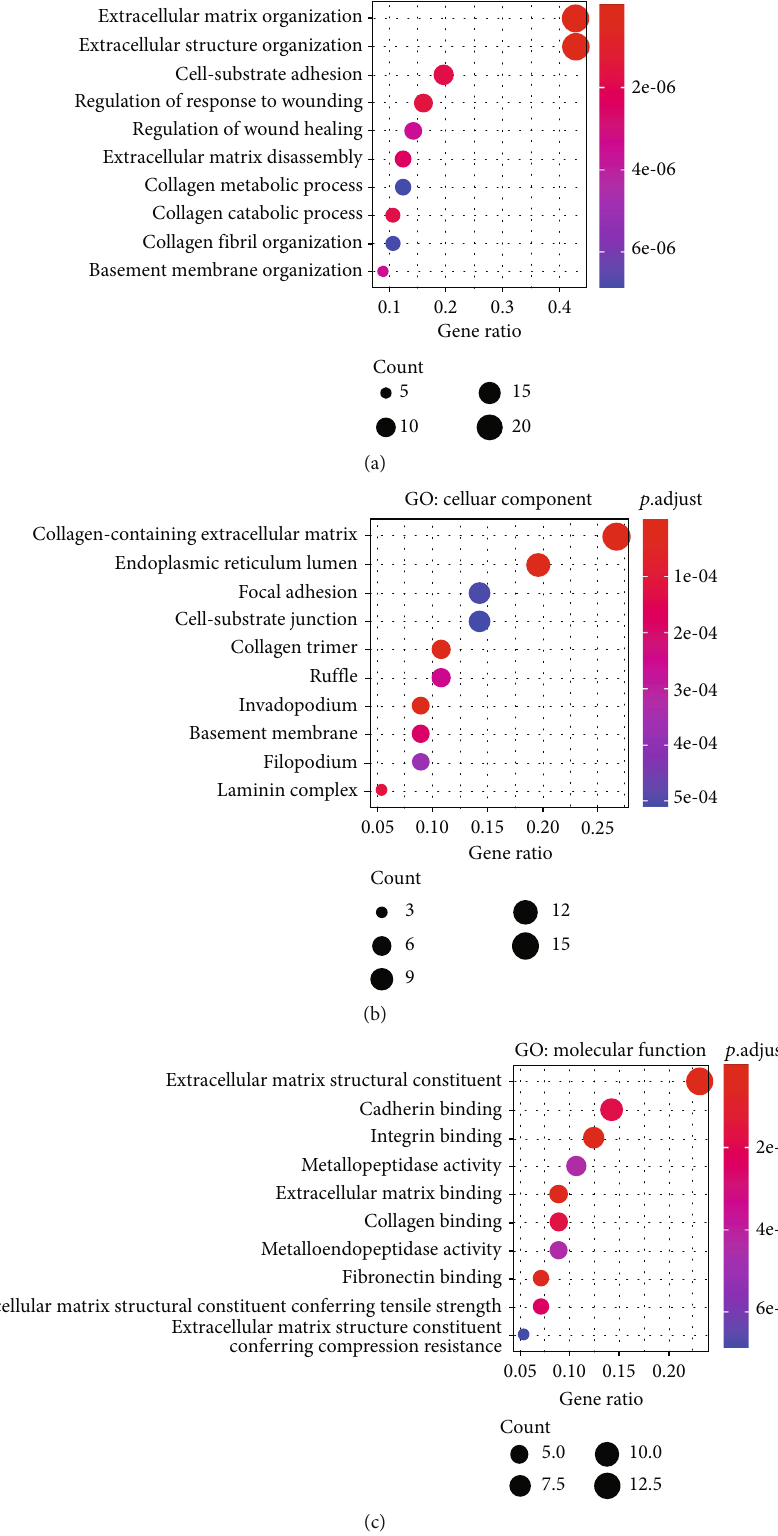
p .adjustGO: celluar